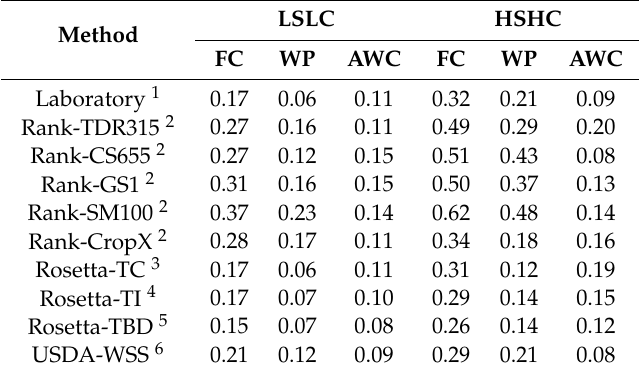
Table 6. Estimates of field capacity (FC), wilting point (WP), and available water content (AWC) (all in m 3 m − 3 ) obtained from various